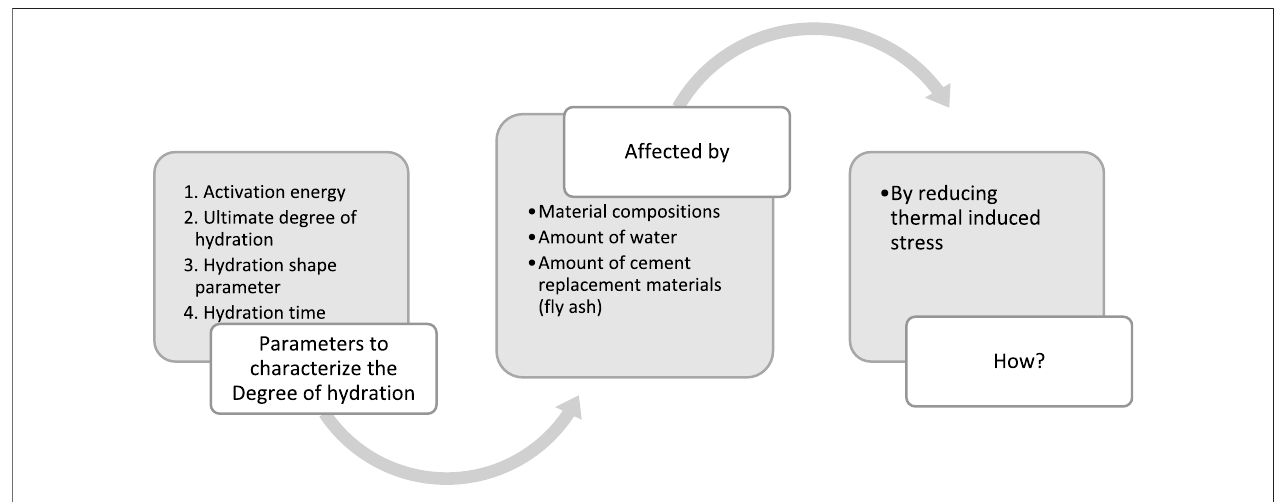
FIGURE 1 | Parameters and process used to characterize cement hydration (summarized from the work of Xu et al., 2010).